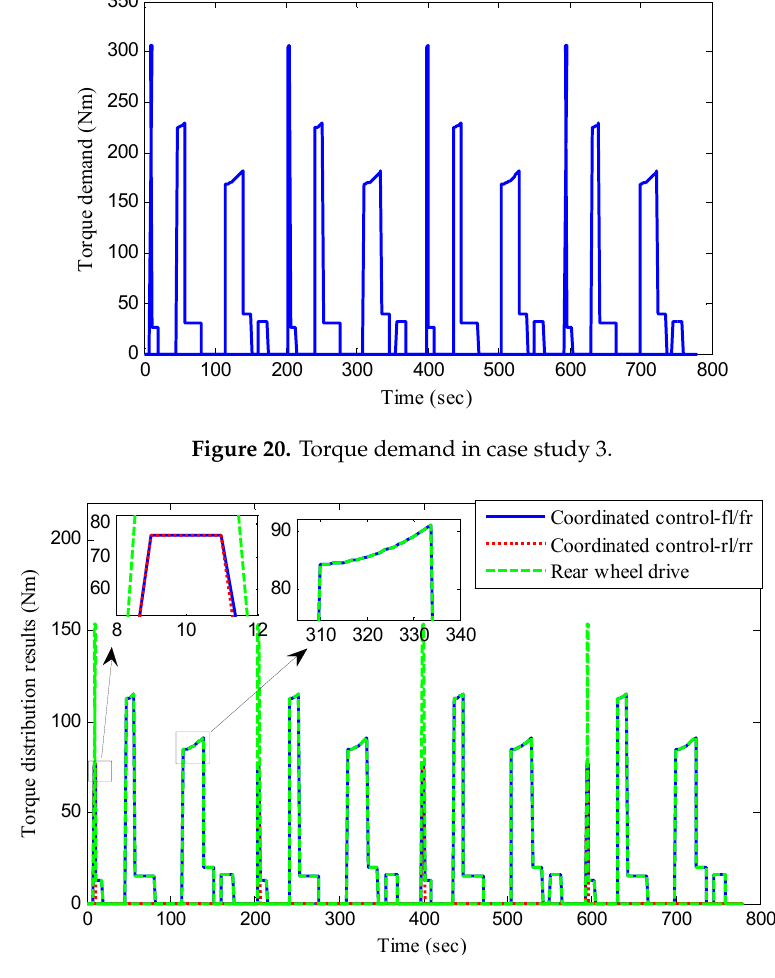
Figure 22. Motor efficiency in case study 3. Figure 23. Total motor load power in case study 3. 6. Conclusions This paper presents a hierarchical coordinated control method of an in-wheel motor drive electric vehicle based on energy optimization. The driving architecture and control network